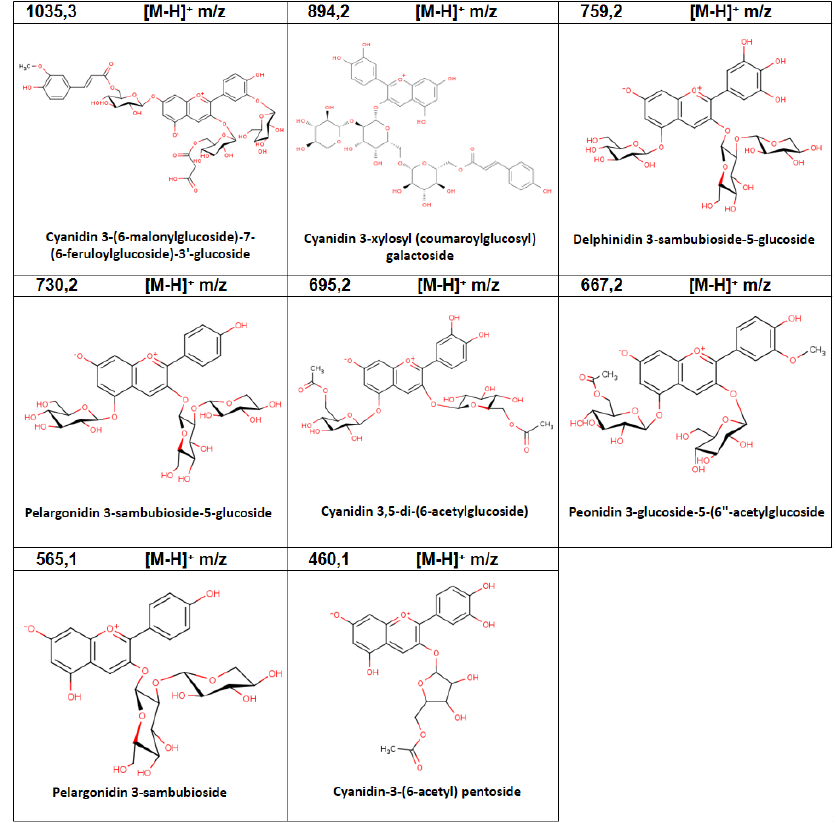
Table 3. Anthocyanins identified by LC ‐ MS/MS analysis for aqueous extracts of in vitro plant of A. chilensis .